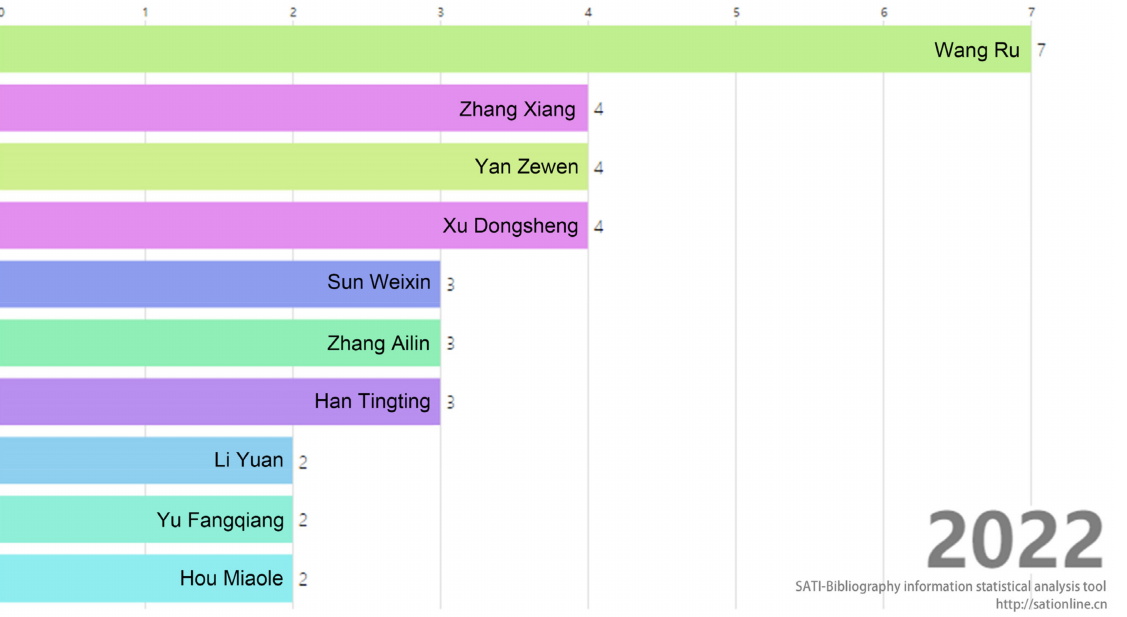
Figure 7. Ranking of core authors’ publications on the topic of “BIM” and “architectural heritage” from 2007 to 2022 (167